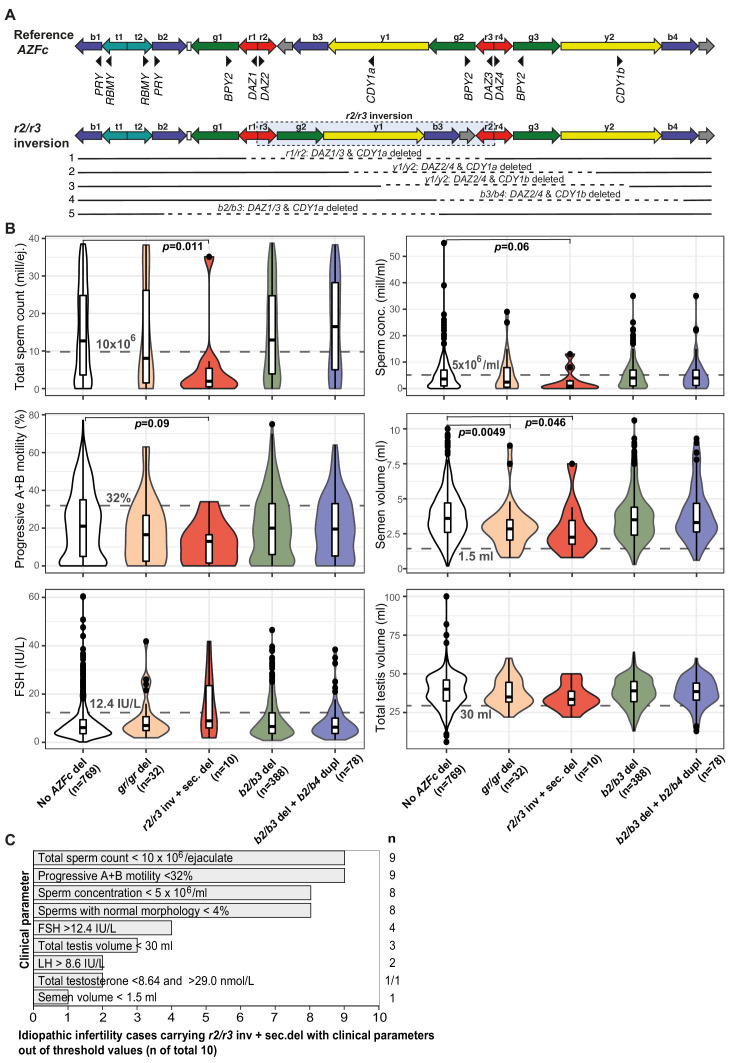
Complex structural variants at the Y-chromosomal lineage R1a1-M458 and their effect on andrological parameters.(A) Schematic presentation of the Y chromosome with the r2/r3 inversion compared to the reference sequence. The r2/r3 inversion structure nearly destroys the large palindrome P1 and, consequently, destabilizes the AZFc region since several long DNA amplicons with highly similar DNA sequence (b2, b3, and b4; g2 and g3; y1 and y3) are positioned in the same sequence orientation. This structure promotes non-allelic homologous recombination mediating recurrent deletion and duplication events. The approximate regions removed by the identified gr/gr and b2/b3 deletions arising on the r2/r3 inverted Y chromosome are shown as dashed lines. (B) Distribution of andrological parameters in the idiopathic male factor infertility cases (total sperm counts 0–39 × 106) subgrouped based on the structure of the AZFc region. The pairwise Wilcoxon rank-sum test was applied to estimate the statistical difference between groups (Bonferroni threshold for multiple testing correction, p<1.0×10−3). Threshold values (shown in gray) for sperm parameters corresponding to severe spermatogenic failure are based on international guidelines (World Health Organization, 2010). For reproductive hormones, reference values of the laboratory service provider are shown. The empirical threshold for the total testis volume was based on routinely applied clinical criteria at the AC-TUH. For additional details, see Figure 3—figure supplements 1–3, Supplementary files 3 and 12. (C) The majority of idiopathic infertility cases carrying the r2/r3 inversion plus secondary AZFc partial deletions (total n = 10) exhibit severe oligoasthenoteratozoospermia (OAT) defined as extremely reduced sperm counts (<5 × 106/ml) and concentration (<10 × 106/ejaculate) combined with low fraction of sperms with normal morphology (<4% normal forms) and motility (<32% progressive motile spermatozoa). Reference values for andrological parameters have been applied as referred in (B). As total testis volume is mostly within the expected range, their infertility is not caused by intrinsic congenital testicular damage but rather due to severe spermatogenic failure per se. Del, deletion; inv, inversion; dupl, duplication; n, number; sec, secondary; mill, million; ej., ejaculate.